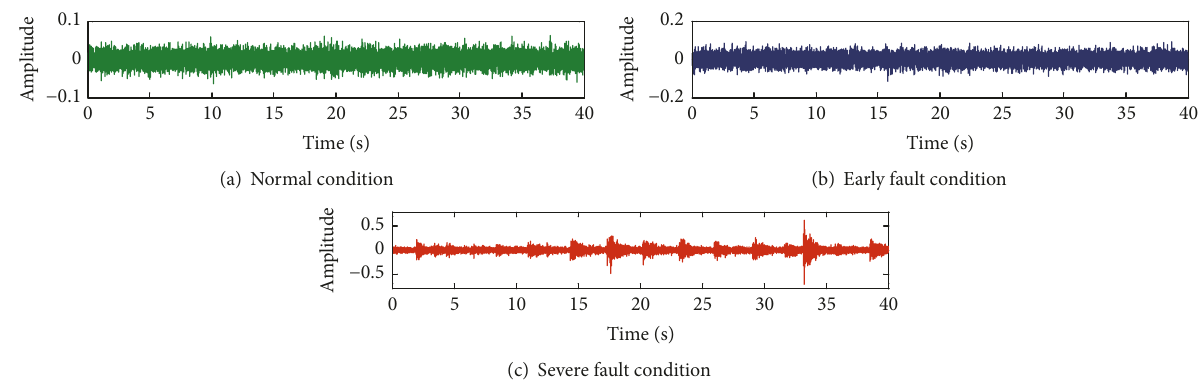
Figure 6: Time-domain signals of various conditions after MCKD (the data were acquired on Oct. 15, 2015; Oct. 25, 2016; and Oct. 26, 2017, resp.).